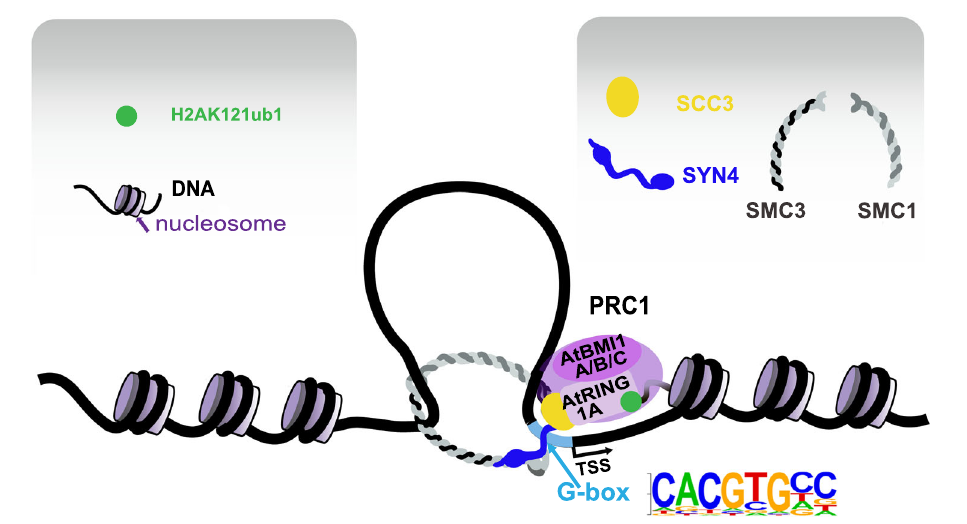
Fig. 7 |A proposedmodelforthemechanismelucidating thespeci fi c targeting of H2Aub1 to G-box-containing loci through cohesin. The cohesin subunit AtSYN4bindstotheG-boxmotifupstreamoftheTSS,whereAtSCC3interactswith